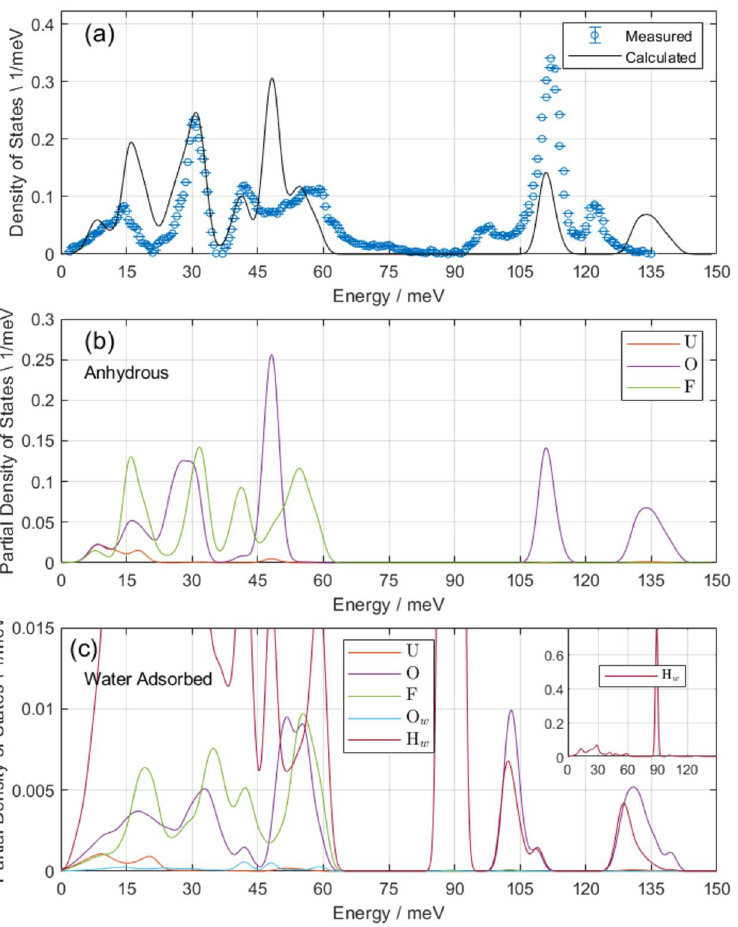
Figure 3. In panel (a), comparison of calculated neutron-weighted (“generalized”) phonon density of states based on phonon eigenvectors and frequencies as calculated via DFT (black line) with measured density of states (blue circles). The calculated values are determined via Equation 1 with a 48 × 48 × 48 k-point mesh sampling the Brillouin zone. The mesh sampling is done via phonopy 31 . Data from measurements of the phonon spectrum with 20, 80, and 175 meV incident energy neutrons are knit together using a self-consistent procedure as implemented in the Mantid data reduction suite and multiphonon package 12–14 . The knitting allows a faithful comparison to the calculated density of states, preserving both the better energy resolution provided by lower energy neutrons and the higher dynamic range of higher energy neutrons. The calculated and measured densities of states agree well with regard to the frequencies of major peaks. The major qualitative differences are a shifting to higher energy and broadening of the 50 meV peak (uranyl bending mode), overestimation of the frequency of the asymmetric uranyl stretching mode (observed at 122 meV), and an underestimation of the intensity of the symmetric uranyl stretching mode. In panel (b), element-decomposed (partial) density of states for U, O, and F atoms as calculated via DFT for the anhydrous structure, shows that a mix of O and F motion dominates below 60 meV, and O motion dominates in the uranyl stretching region. In panel (c), the partial density of states for the water-adsorbed structure shows softening of the 50 meV peak, but due to its large neutron cross-section and small mass, H is the primary contributor to the density of states. The inset in panel (c) shows only H contributions, with a single major peak at 89 meV, corresponding to unhindered librational ( R z )